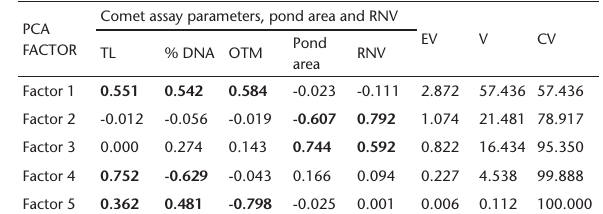
vegetation.M.W. Table 2. Results from a principal component analysis of comet assay parameters, related to pond area and remnant native vegetation (RNV). The factors loading for all three comet assay parameters, pond area and RNV and those higher than 0.05 are in bold. (TL) Tail length, (% DNA) % DNA in tail, (OTM) Olive tail moment, (EV) eigenvalue, (V) variance (%), (CV) Cumulative variance (%). Figure 3. Principal component analysis (PCA) of the descriptor variables and the covariate pond area. Relationship between the PCA 1 and PCA 2, points were grouped according to the soybean (white triangle), corn (white circles) and non-agricultural lands (black circles). (TL) Tail Length, (% DNA) percentage of DNA in Tail, (OTM) Olive tail moment, (RNV) Remnant native ZOOLOGIA 34: e19865 | DOI: 10.3897/zoologia.34.e19865 | August 10, 20174 /